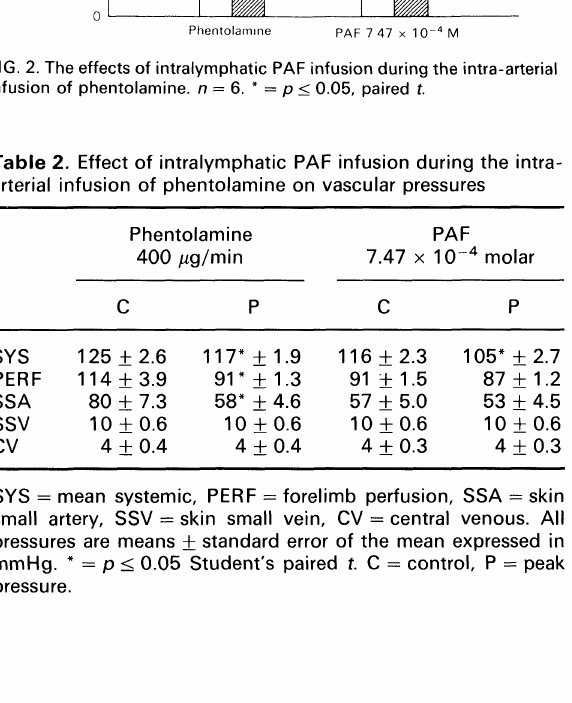
SYS mean systemic, PERF- forelimb perfusion, SSA- skin small artery, SSV- skin small vein, CV central venous. All pressures are means 4- standard error of the mean expressed in mmHg.